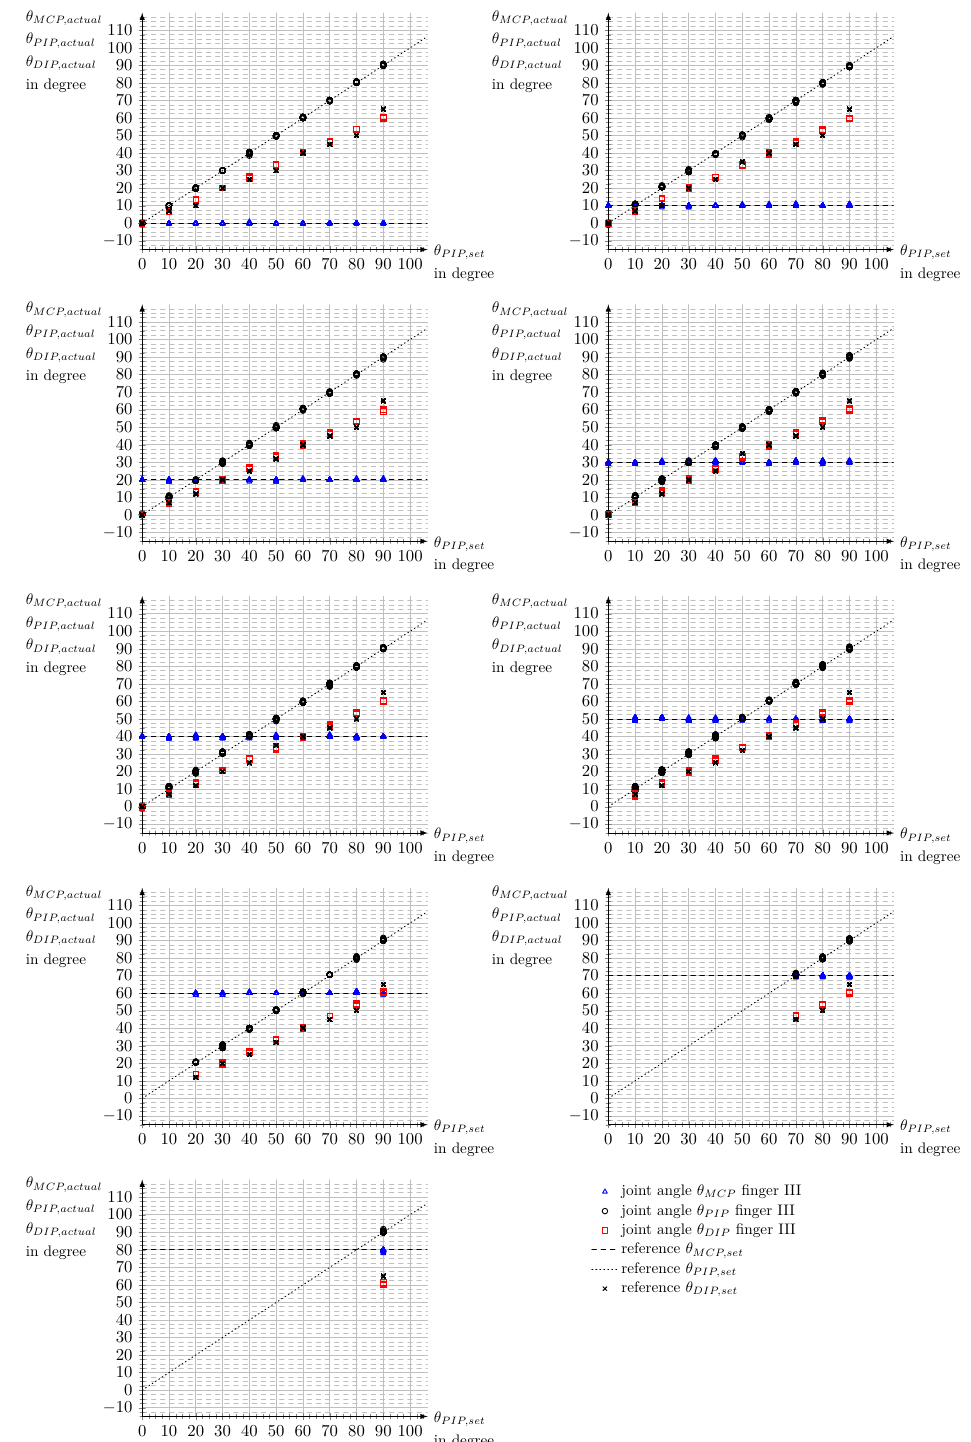
Figure A6. Accuracy of measurement for finger III. Joint angles θ set for the Metacarpophalangeal (MCP) joint from θ MCP , set = 0° to θ MCP , set = 80° and for the Proximal Interphalangeal (PIP) joint θ PIP , set . Reference for the Distal Interphalangeal (DIP) joint θ DIP , set calculated in dependence on θ PIP , set . Joint angles θ MCP , actual and θ PIP , actual measured with SenGlove. θ DIP , actual calculated in dependence on θ PIP , actual